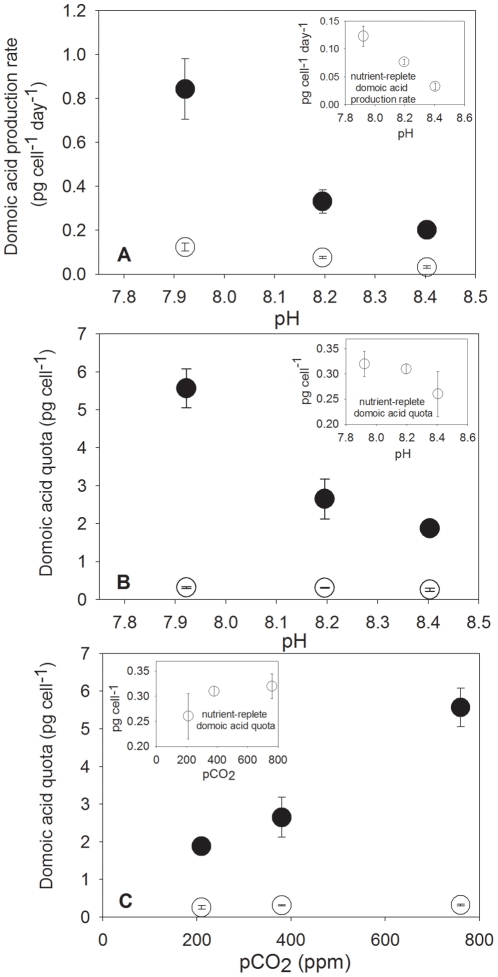
Interactive effects of pH and pCO2 with nutrient limitation control Pseudo-nitzschia fraudulenta toxicity.Cellular domoic acid production rates (pg cell−1 day−1) versus pH (a) and domoic acid quotas (pg cell−1) versus pH (b) and pCO2 (c) in Pseudo-nitzschia fraudulenta cultures grown under Si(OH)4-limited (•) and nutrient-replete (○) conditions at seawater CO2 concentrations of 200 ppm (preindustrial atmospheric levels), 360 ppm (modern levels), and 765 ppm (projected year 2100 levels). Panel insets present the nutrient-replete data with an expanded Y-axis scale for clarity. Error bars represent standard deviations of triplicates for each treatment.